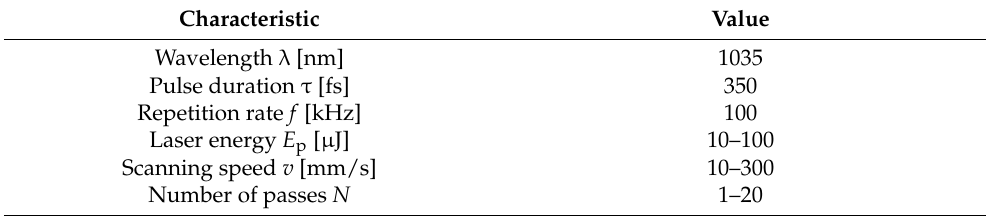
Table 1. The processing parameters applied for femtosecond laser